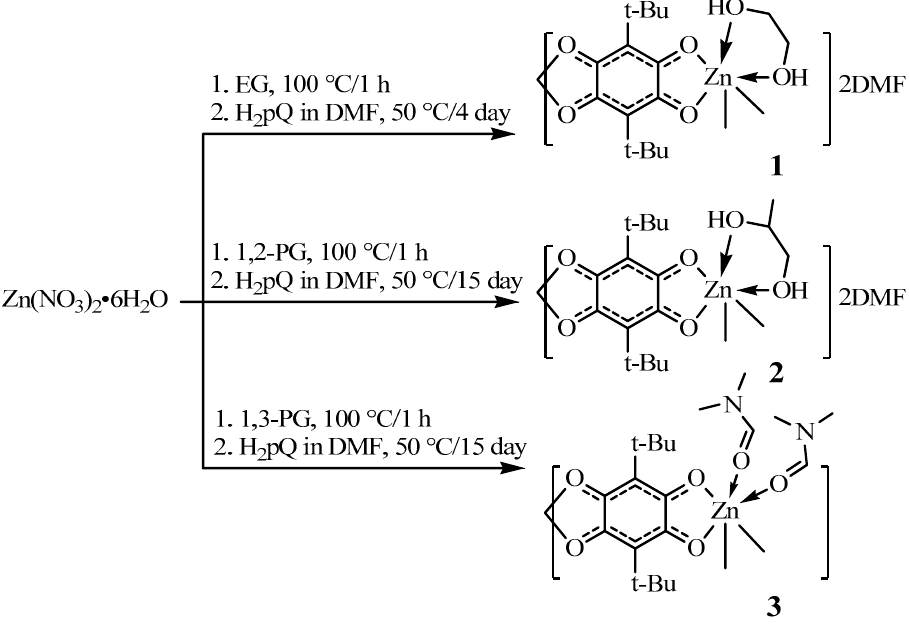
Figure 2. Synthesis of compounds 1 – 3 .